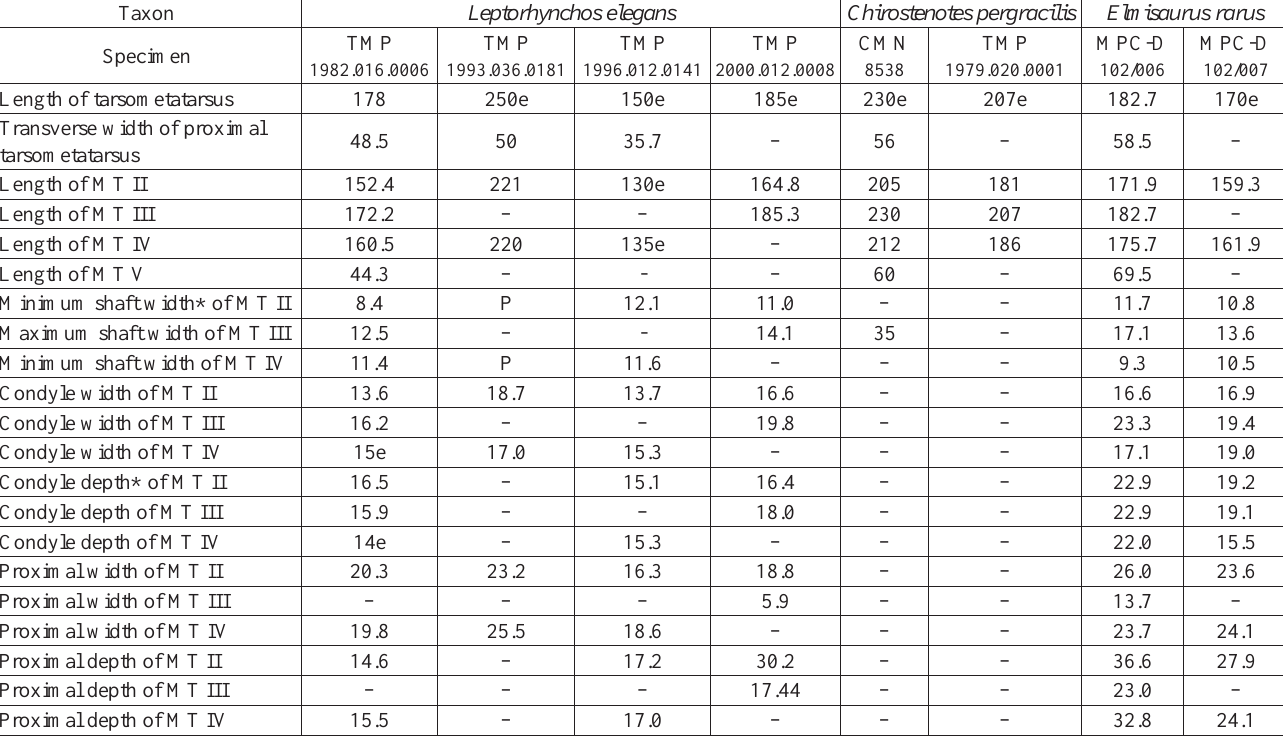
Table 1. Measurements (in mm) of elmisaurine and caenagnathine metatarsi from Campanian–Maastrichtian of Canada. *, width refers to trans- verse (mediolateral) breadth, and depth refers to anteroposterior thickness; e, estimated; MT, metatarsal; P, pathological.